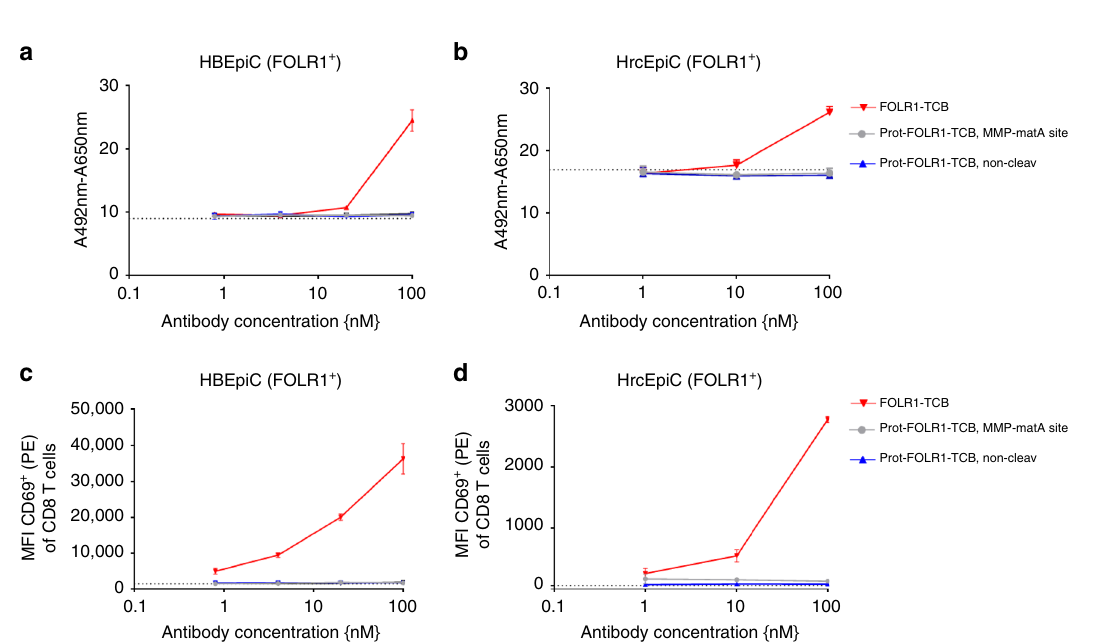
Fig. 5 Prot-FOLR1-TCB is ef fi ciently blocked while its potency can be fully restored upon linker cleavage. Dose – response curves for T-cell killing of FOLR1-positive tumor cells after 48 h mediated by TCB using PBMCs as effector cells with an E:T of 10:1. a , b Comparison of Prot-FOLR1-TCB (noncleavable and precleaved with matA site) for tumor cells with different FOLR1 expression levels ( a HeLa cells, b Skov-3 cells). The cytotoxicity induced by the antibodies is shown. Each point represents the mean of triplicates. Standard deviation is indicated by error bars (representative experiment for one PBMC donor, n = 2 different human PBMC donors). c , d The cytotoxicity induced by the Prot-FOLR1-TCB containing MMP-matA site is shown. The Prot-FOLR1- TCB containing an MMP-matA site (gray circles) or a noncleavable linker (blue triangles pointing up) is shown. FOLR1-TCB (red triangles, pointing down), precleaved Prot-FOLR1-TCB (orange squares) and a nontargeted TCB (black circles) are used as controls. The cytotoxicity of the Prot-FOLR1-TCB with a noncleavable linker was only measured for four concentrations using Skov-3 cells as the target cells. The nontargeted TCB was only used at the three highest concentrations for both cell lines. The pretreatment of the Prot-FOLR1-TCB (orange squares) was done by incubation of Prot-FOLR1-TCB with recombinant human matriptase for 24 h at 37 °C. Each point represents the mean of triplicates. Standard deviation is indicated by error bars (representative experiment for one PBMC donor, n = 3 different human PBMC donors). e , f Granzyme B release was quanti fi ed by FACS analysis after incubation of PBMCs with 10 nM of Prot-FOLR1-TCB (cleavable linker vs. noncleavable linker) and FOLR1-positive target cells for 48 h. Each point represents the mean value of triplicates. Standard error is indicated by error bars (representative experiment for one PBMC donor, n = 3 different human PBMC donors). g FOLR1-positive tumor cell (CellPlayer ™ MDA-MB-231 NucLight Red) growth inhibition mediated by Prot-FOLR1-TCB containing MMP- matA site and human PBMCs. Each point represents the mean of triplicates. Standard deviation is indicated by error bars (representative experiment for one PBMC donor, n = 2 different human PBMC donors).